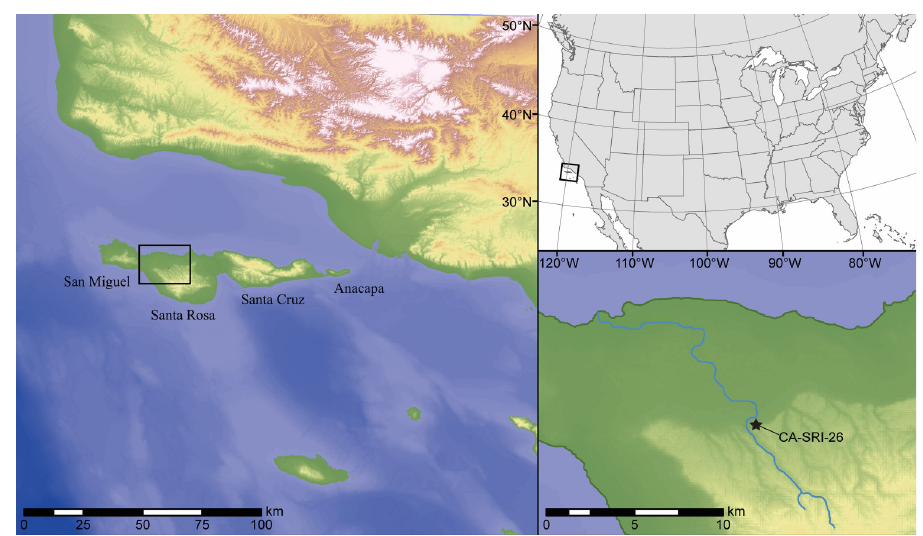
Fig 1. Estimated position of Alta California’s Channel Islands and mainland coast when CA-SRI-26 was occupied, and the approximate course of Arlington Creek. The paleo-digital elevation model, which forms the image background and is the basis for both the shoreline and stream estimates, was produced using the methods from Reeder-Myers et al. [13], but with an updated model of glacio-isostatic adjusted sea level from Argus et al. [17] and Peltier et al. [18]. CA-SRI-26 was about 6 km from the contemporary shoreline in a straight line, but about 15.5 km if following the course of the stream to its mouth. Relative sea level ~11,700 years ago on the northwest coast of Santa Rosa Island is estimated at -60 ± 5 m and highlighted in dark green. Drafted by Leslie Reeder-Myers.